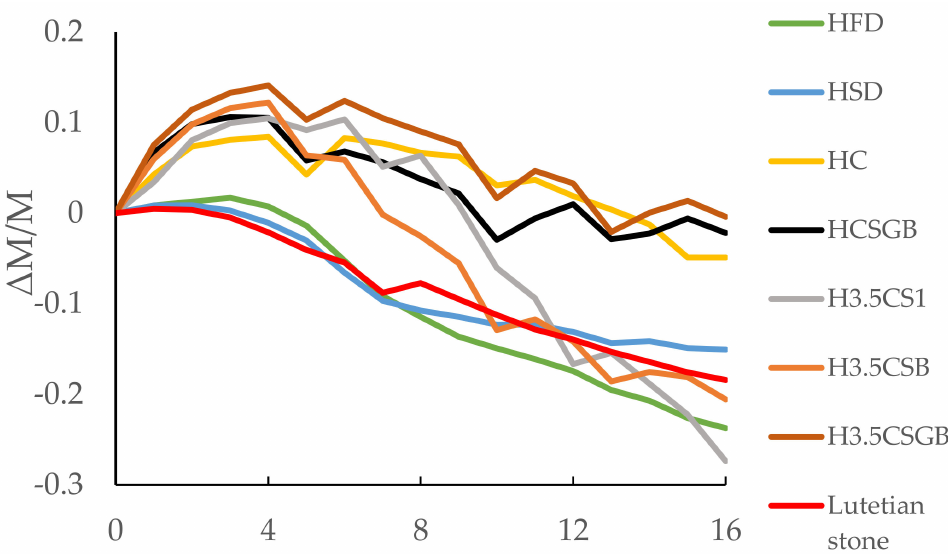
Figure 3. Result of the salt crystallization test for selected mortars.